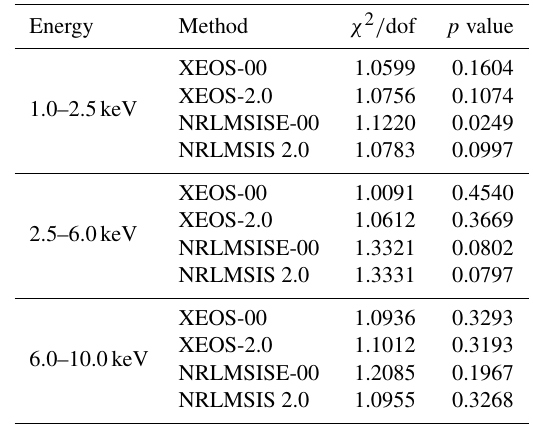
Table 4. Hypothesis testing results for the extinction curve predic- tions with XEO-measured density profiles and NRLMSISE-00- and NRLMSIS 2.0-model-simulated density profiles (during the occul-